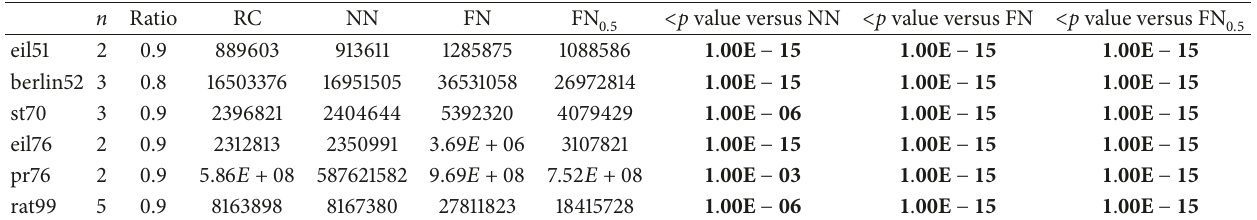
Table 2: Results of the RC algorithm versus the NN, the FN, and the FN 0.5 algorithms for asymmetric